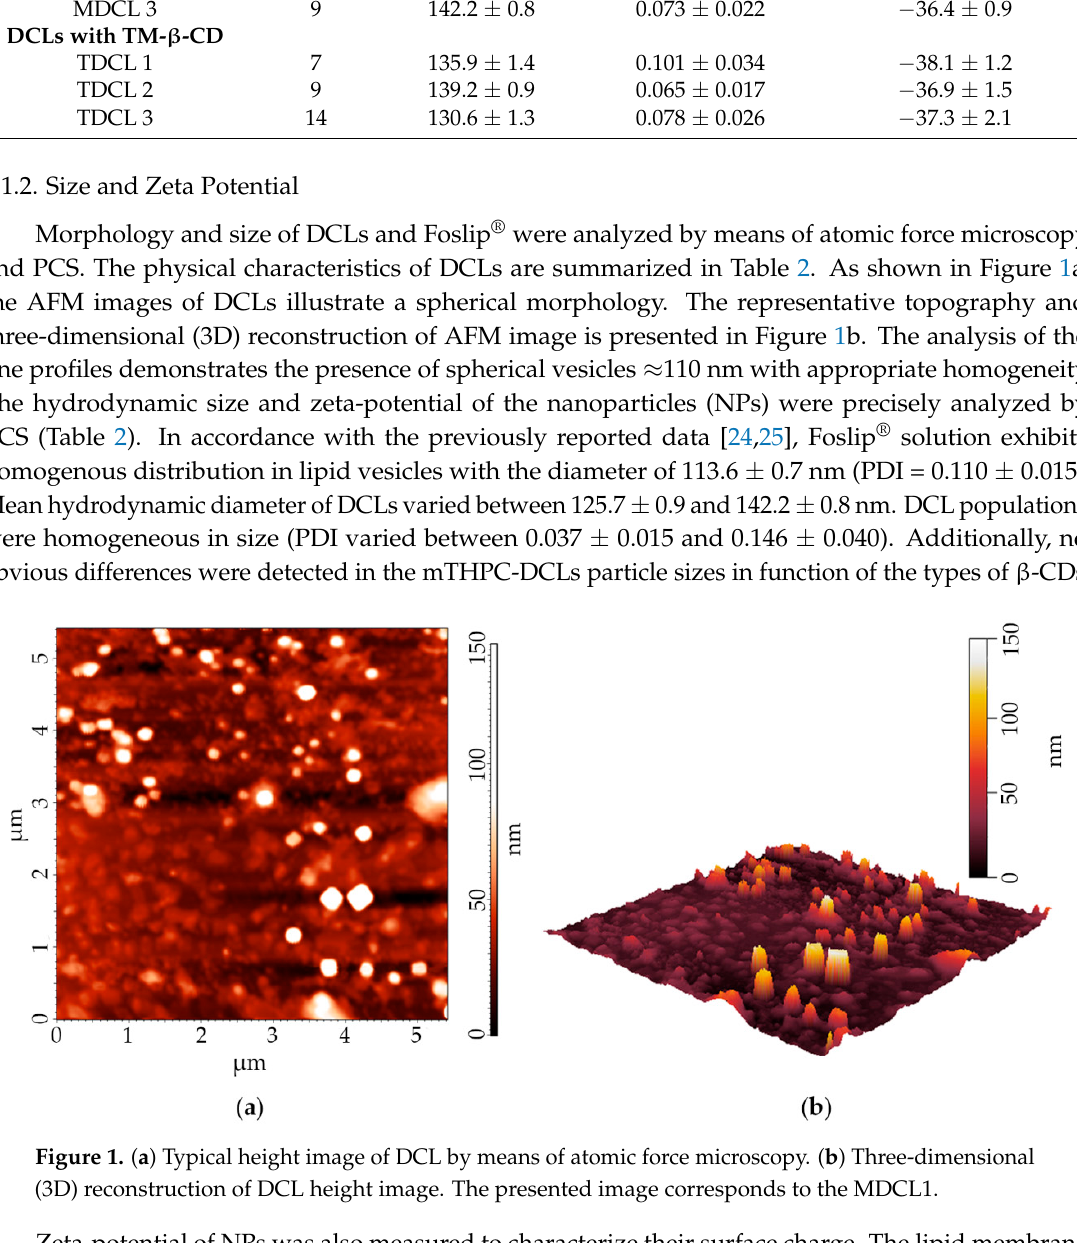
Table 2. Characterization parameters of different liposomal formulations of mTHPC.